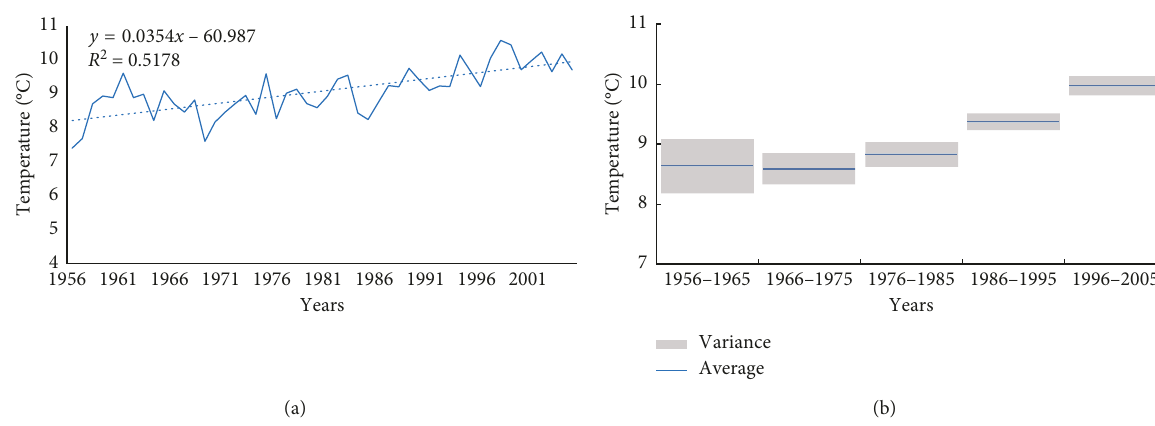
F IGURE 6: (a) Interannual variation in the annual mean temperature and (b) the average temperature change over ten